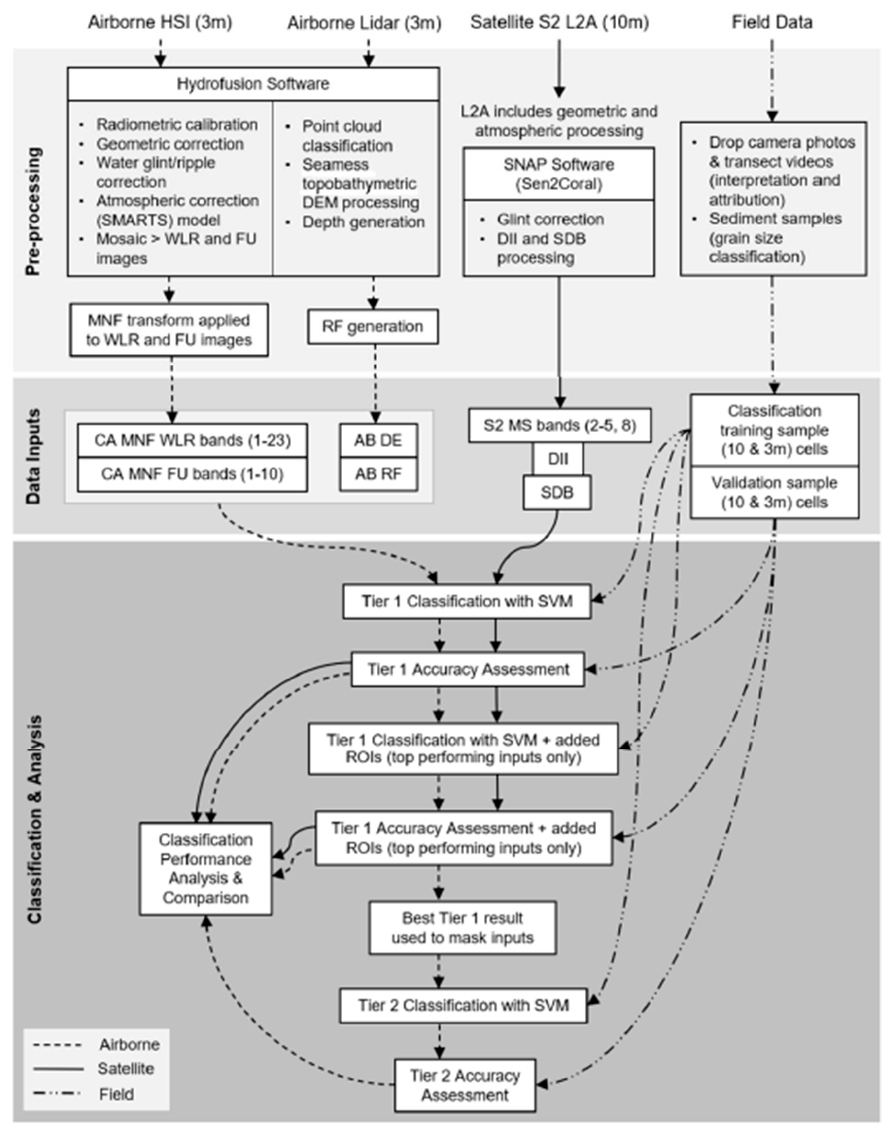
Figure 9. Remote sensing workflow illustrating pre-processing, classification inputs, and classifica-